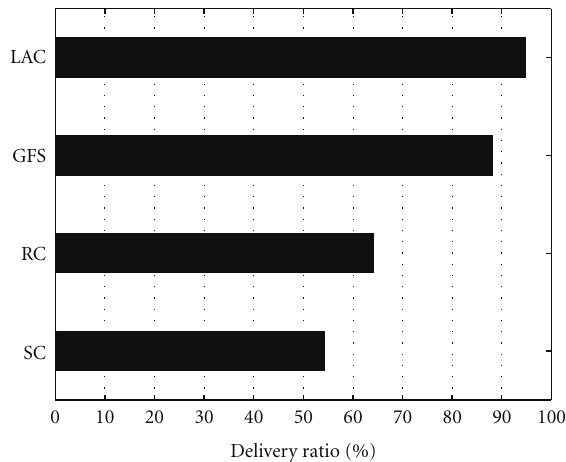
Figure 8: Average delivery ratio with video tra ffi c.